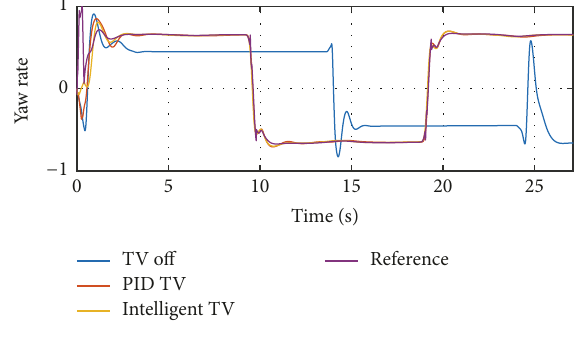
Figure 16: Yaw rate tracking.